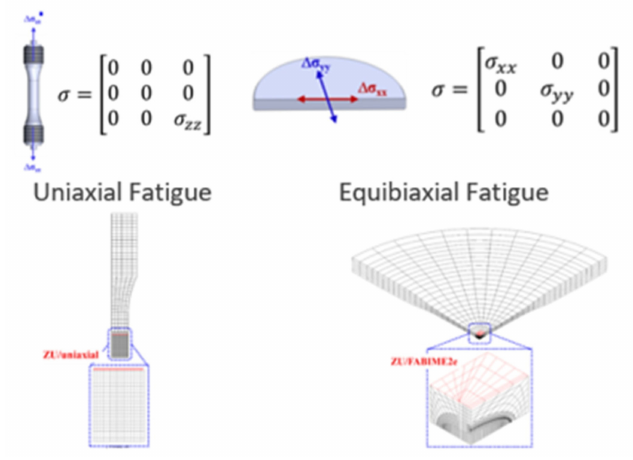
Figure 9. Difference stress tensor on uniaxial and equibiaxial specimens. Numerical simulations of the FABIME2 tests were carried out with the FE Software Cast3M. Different semi-elliptical crack sizes were studied, starting from a solid specimen up to a crack size of 10 mm (dimension of the useful area) (see Figure 10). For each crack size, the simulations were performed, taking into account the nonlinearity of the material behavior using an elasto-plastic behavior model stabilized with nonlinear isotropic and kinematic strain-hardening.